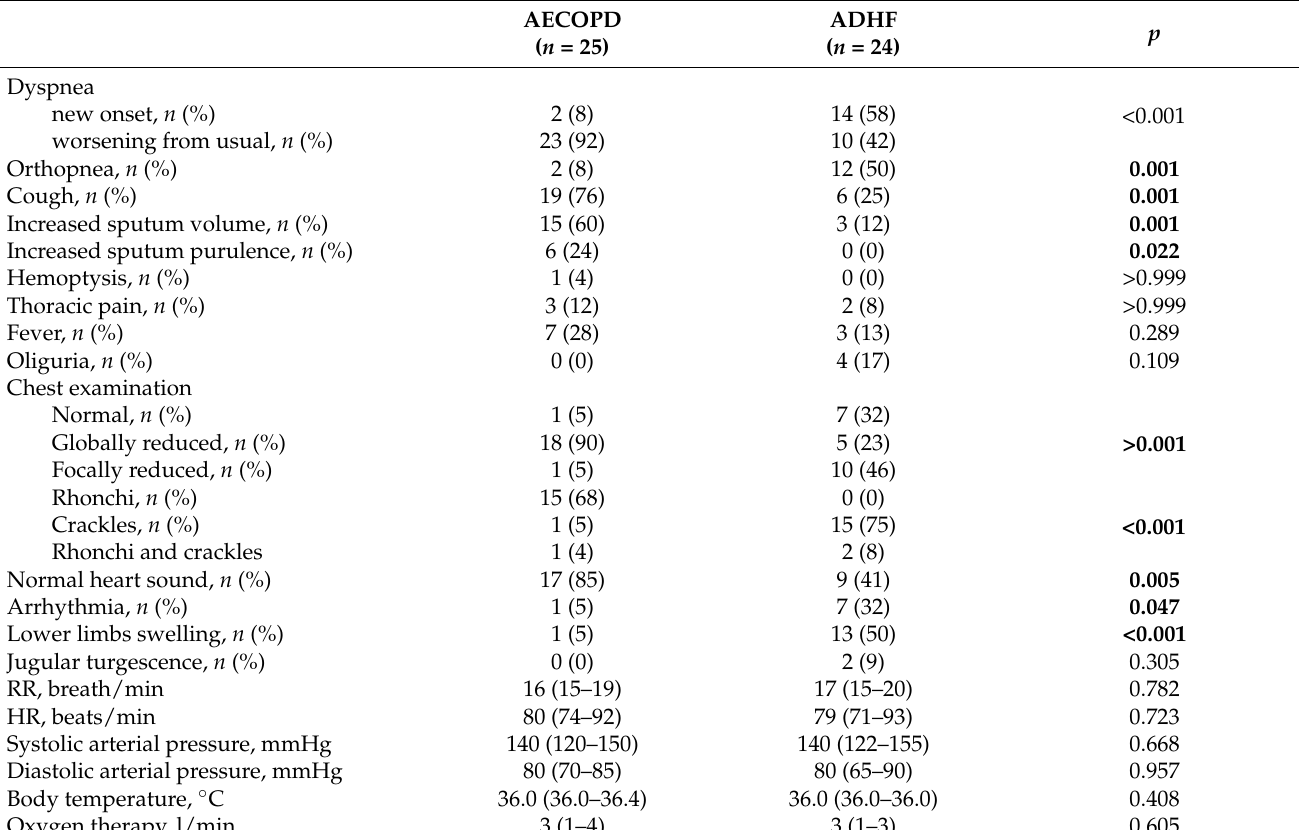
Table 2. Symptoms and physical examination at presentation at emergency department.